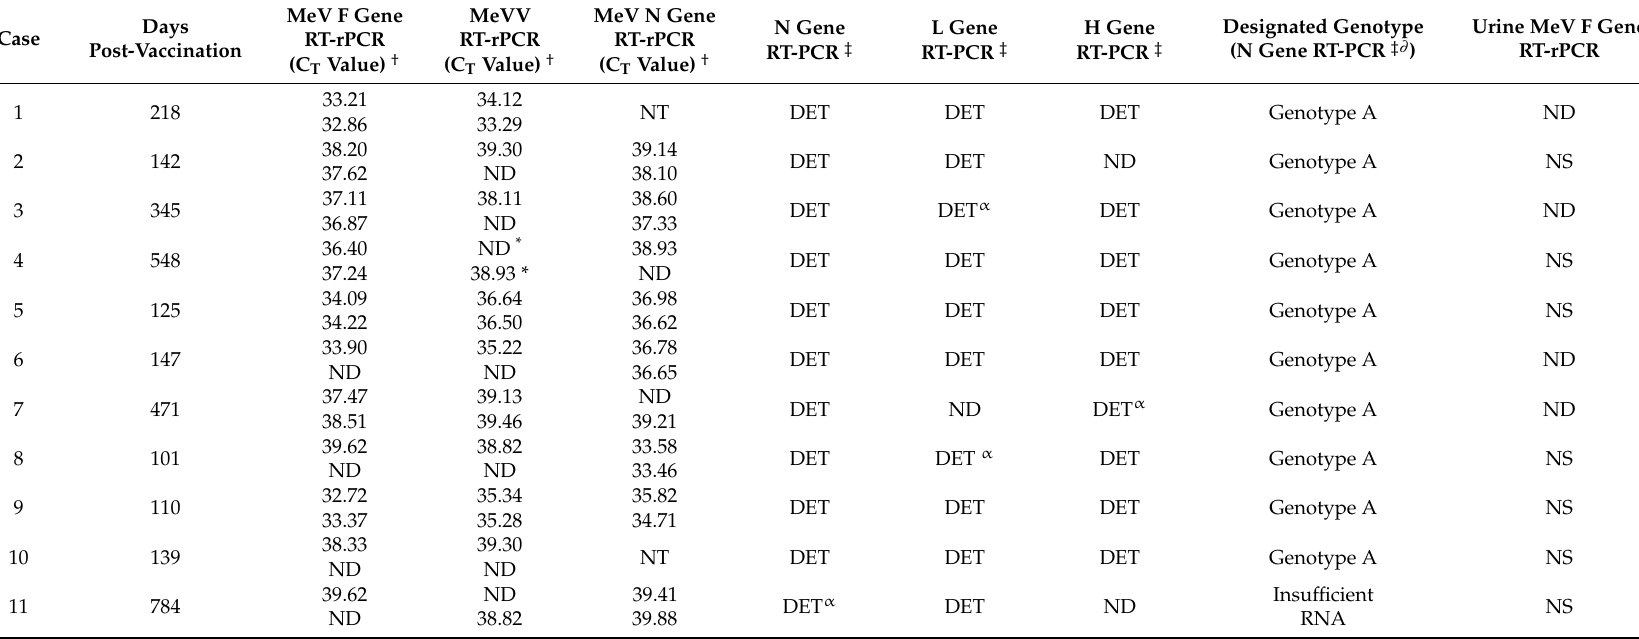
Table 2. Summary of MeV